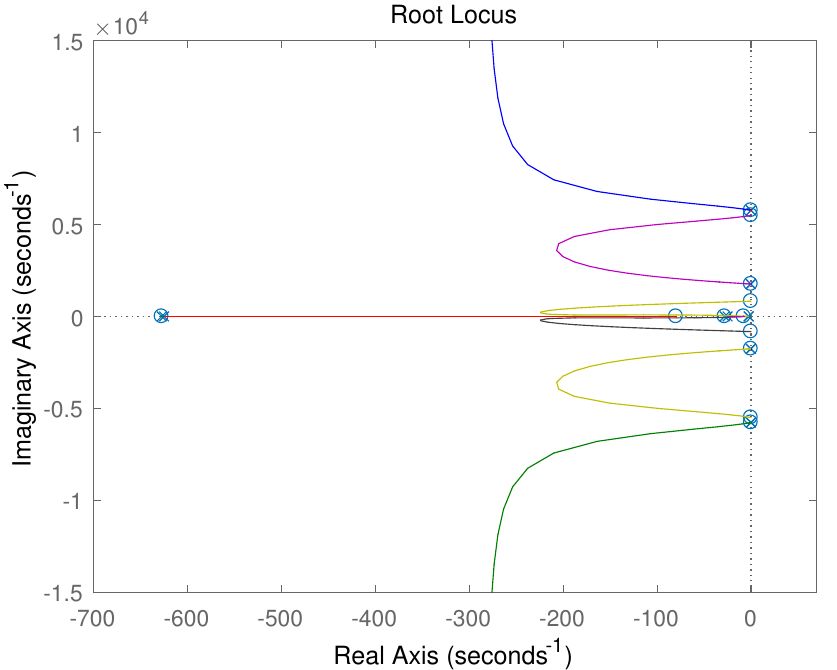
Figure 5. Root locus under the fractional-order PD controller K p = 1408.5, K d = 488.1, α = 0.77.